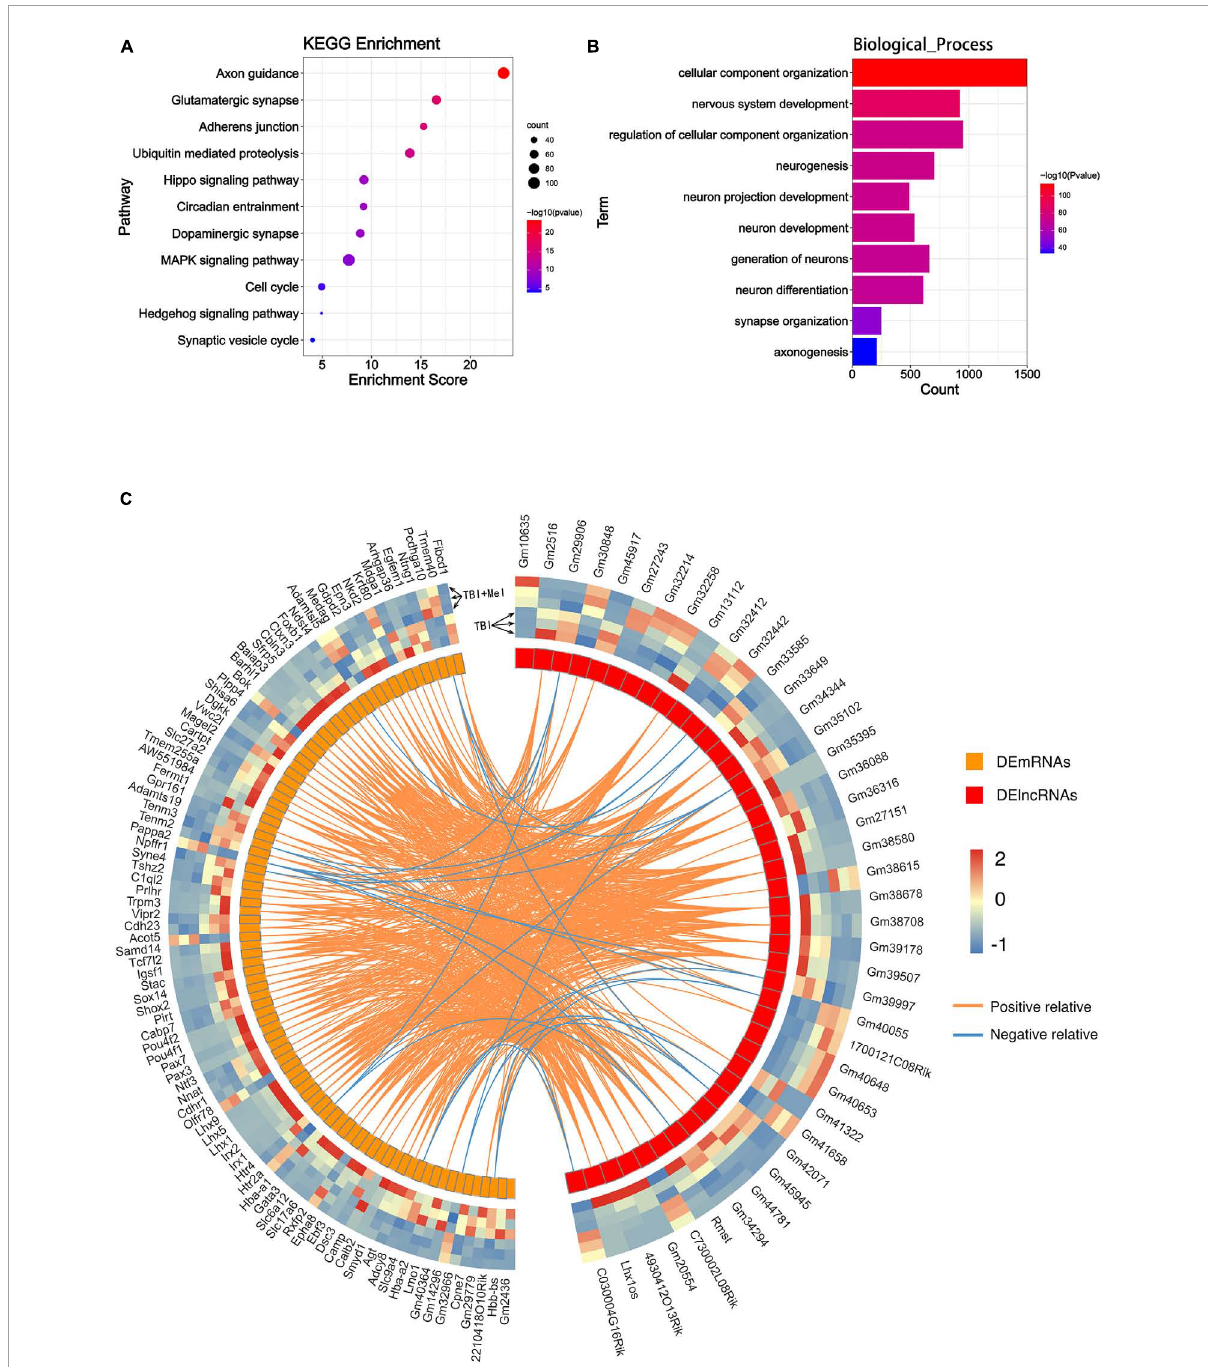
FIGURE5 Function predicting of the DElncRNA and their correlation with DEmRNA. (A) The KEGG enrichment analysis of the target mRNA of RBPs of DElncRNAs. The abscissa enrichment score represents the enriched extent of the pathway, and the ordinate represents each pathway. The size of the dots represents the number of genes in each pathway, the color of the dots represents the -log10 ( p -value), and the p -value was corrected by FDR. (B) The GO_BP enrichment analysis of the target mRNA of RBPs of DElncRNAs. The ontology only covered biological processes. The abscissa represents the count in the GO_BP term, the ordinate represents the GO_BP term, and the color of the column represents the -log10 ( p -value). (C) Circos heatmap shows the correlation coefficient of DElncRNAs and DEmRNAs. The left outermost layer of the circos heatmap is the gene name of DEmRNAs and the right part is the gene name of DElncRNAs. The largest inner circles show the differentially expressed abundance; the left part is DEmRNAs; the right part is the DElncRNAs. The larger inner circles with modules represent each DElncRNA and DEmRNA. The curve inside of the circle represents the relevance between lncRNA and mRNA. Orange and blue curves represent positive and negative correlations,